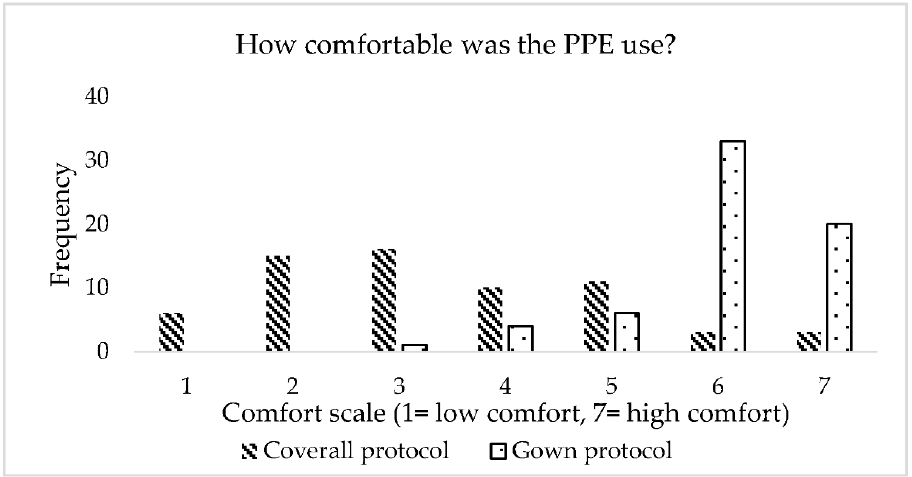
Figure 5. Comfort rating from the perception questionnaire after using the two protocols.